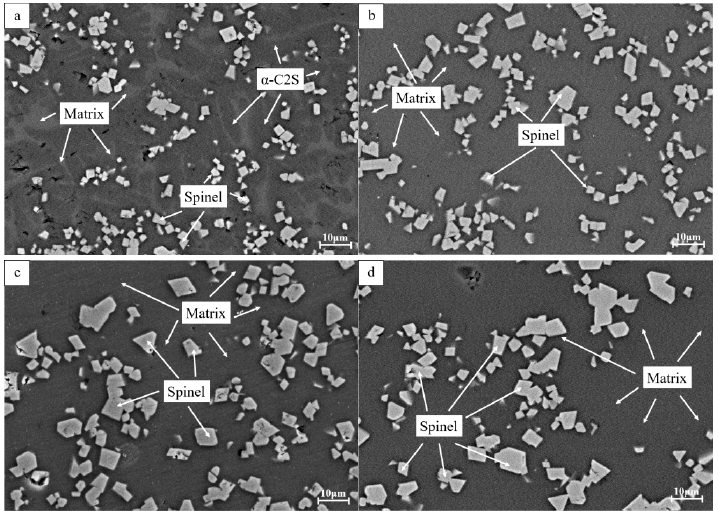
Figure 5. Effects of Fe 2 O 3 on the microstructure of the CaO-SiO 2 -MgO-Al 2 O 3 -Cr 2 O 3 -8 wt % FeO sys-